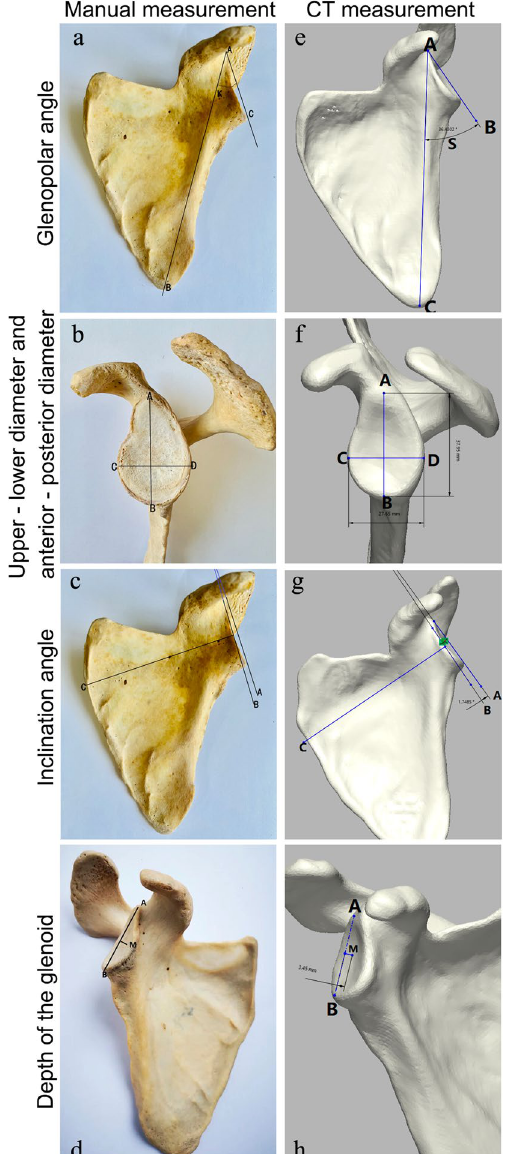
Figure 1. Measurements of the glenoid from dry bone specimens and CT images. ( a , e ) manual measurement and CT measurement of the glenopolar angle. Point A, upper edge of the glenoid. Point B, lower angle of the scapula. Point C, lower edge of the glenoid. Angle K, glenopolar angle (GPA). ( b , f ) Manual and CT measurement of the upper to lower vertical diameter and anteroposterior transverse diameter of the glenoid. AB, upper to lower diameter of glenoid; CD, anterior to posterior diameter of glenoid. ( c , g ) Manual and CT measurement of the inclination angle of glenoid. Line A, distance between the upper and lower margins of the glenoid. Line B, line passing through the midpoint of the glenoid; Line C is perpendicular to Line B. The angle between A and B was the inclination angle of glenoid. ( d , h ) Manual and CT measurements of glenoid depth. Line M, vertical line from the midpoint of the glenoid. AB, line from the upper to the lower margin of the glenoid. The distance from the end of Line M to Line AB from the midpoint of the glenoid socket is the glenoid